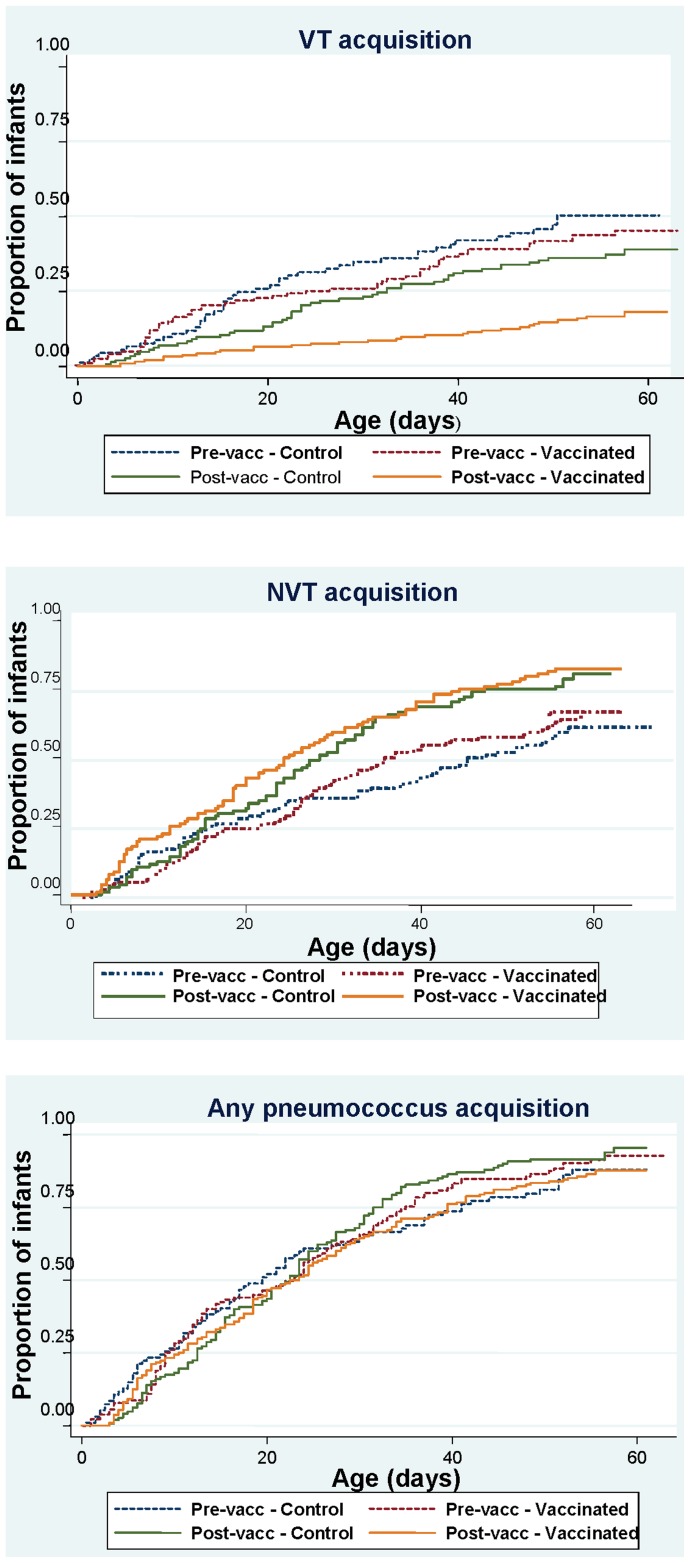
Kaplan-Meier survival curves for time to first acquisition of different serotype groups in the pre-vaccination and post-vaccination surveys by study arm.